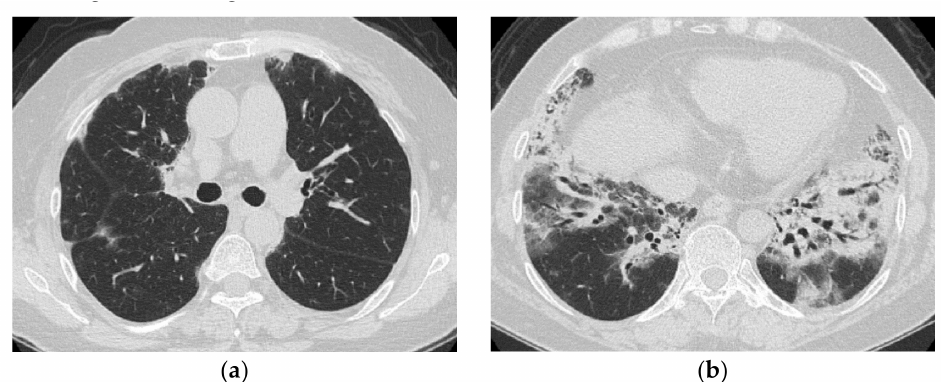
Figure 4. A 50-year-old woman with subacute onset interstitial lung disease associated with der- matomyositis. There is a bilateral basal consolidation extending along the bronchovascular bundles with mild ground-glass opacification and mild traction bronchiectasis within ( b ). Patchy subpleural consolidation is also seen at the level of the pulmonary artery trunk ( a ).